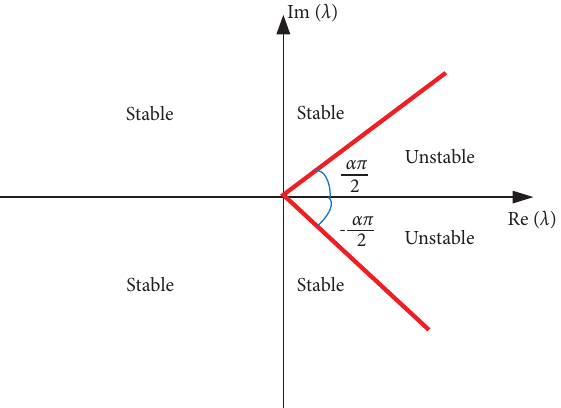
Figure 1: Stability region of the fractional-order system (8), where 0 < α < 1